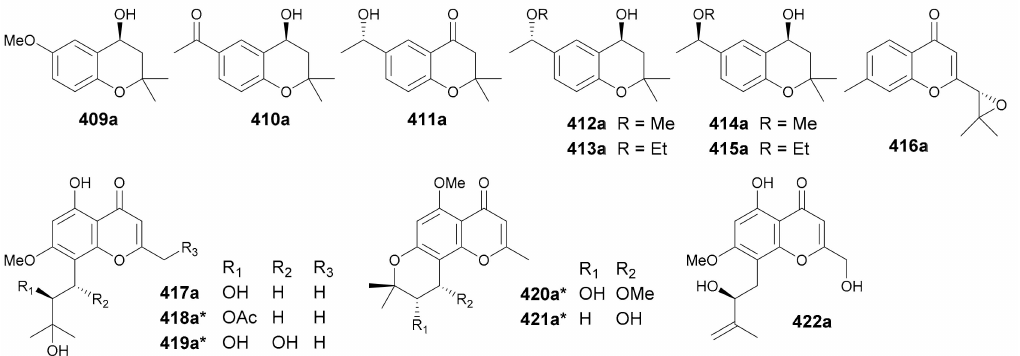
Figure 23. Structures of chromanes (* abs. configs.